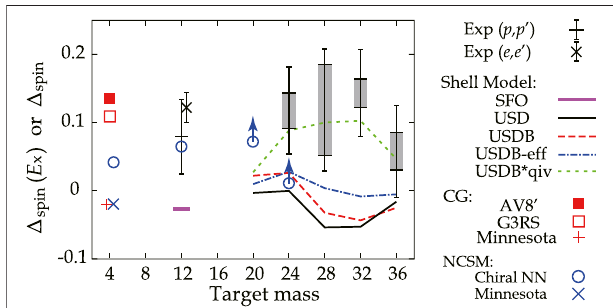
FIGURE10| Experimentaldataof Δ spin ( E x ) summedupto E x (cid:1) 16MeV are plotted for proton (electron) scattering by the horizontal bars (cross mark) with the error bars. The de fi nitions of error bars and gray bands are the same asin Figure8 .Theoreticalpredictionsof Δ spin (cid:1) 〈 S the shell models, Correlated Gaussian (CG) method (Suzuki et al., 2008), and No-Core Shell-Model (NCSM) (Roth et al., 2010). The fi gure was taken from Matsubara et al. (2015) with updated predictions from Sagawa and Suzuki